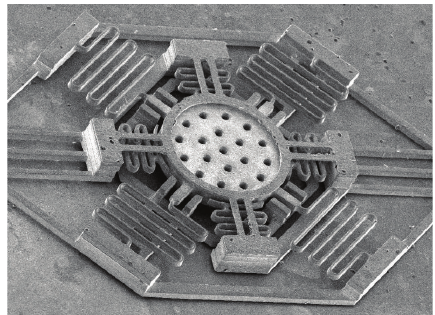
Figure 9: SEM image of the switch prototypes.